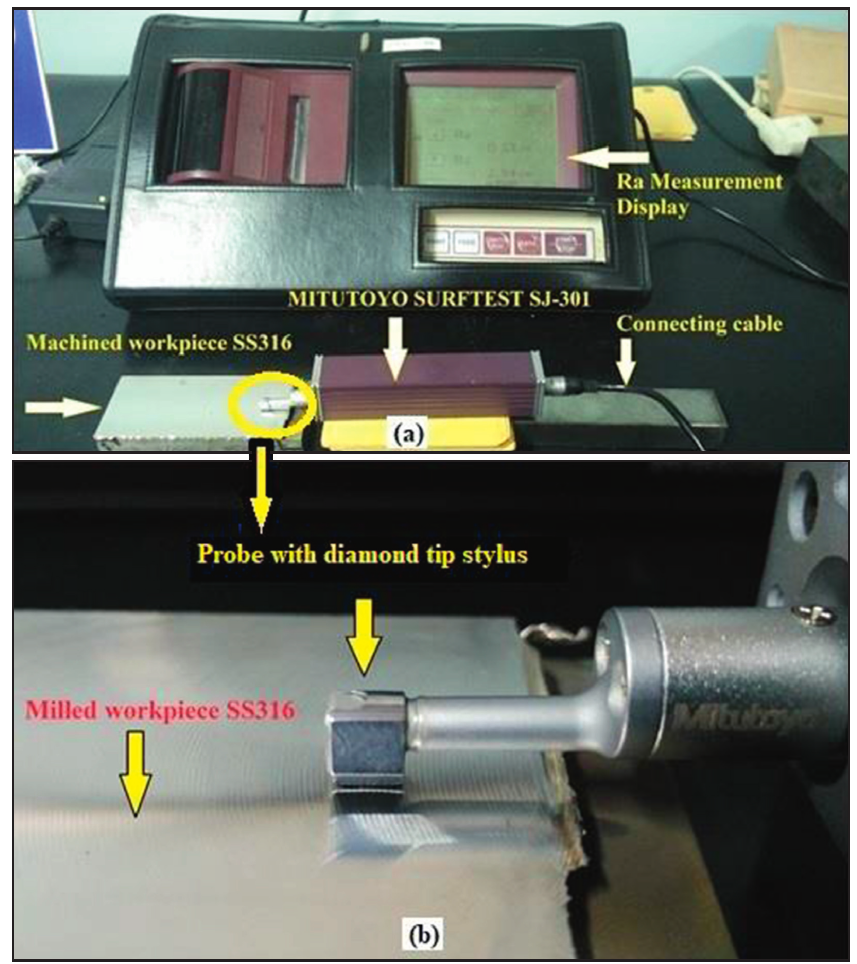
Figure 8: Surface roughness tester (MITUTOYO SURFTEST SJ-301) setup. (a) Surface roughness tester measuring Ra of milled workpiece SS316. (b) Expanded view of the probe with diamond tip stylus of surface roughness